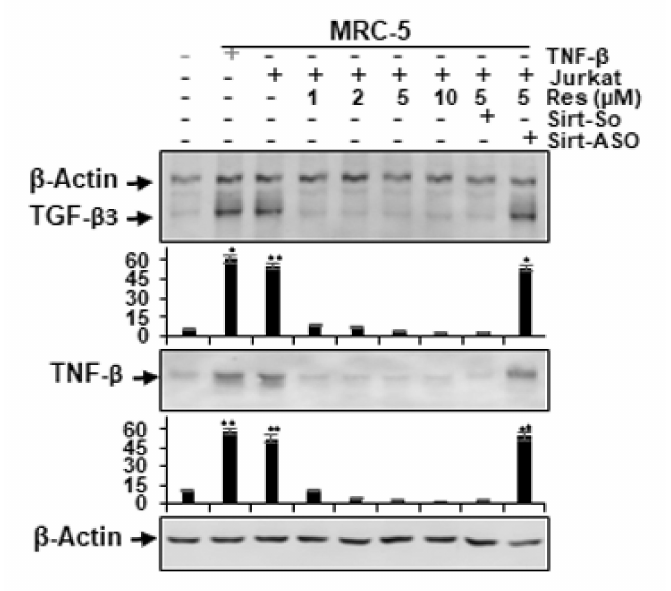
Figure 7. Impact of resveratrol and Sirt1-ASO on TNF- β and TGF- β 3-mediated crosstalk between HCT116 cells and stromal cells in the multicellular-TME. Serum-starved cultures of HCT116 cells in 3D alginate cultures alone (basal control = co) or co-cultured with fibroblasts and TNF- β (10 ng / mL) (TNF- β -TME) or co-cultured with fibroblasts and T-lymphocytes (pro-inflammatory multicellular-TME) were either left untreated, or multicellular-TME cultures were treated with various doses of resveratrol (1, 2, 5, 10 µ M), or transfected with 0.5 µ M sense oligonucleotide (SO), or antisense oligonucleotides (ASO) against Sirt1 in the presence of Lipofectin transfection reagent (10 µ L / mL) and co-treated with resveratrol (5 µ M) for 14 days in alginate cultures, as described in Material and Methods. Whole cell lysates were prepared and analyzed by Western blotting with antibodies against TNF- β and TGF- β 3. β -actin served as an internal loading control in all experiments. * p < 0.05, ** p < 0.01 relative to basal